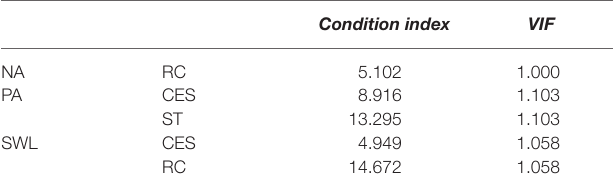
NA, Negative Affect; PA, Positive Affect; SWL, Satisfaction with Life; CES, Centrality Event Scale; RC, Religious Crisis; ST, Spiritual Transcendence.